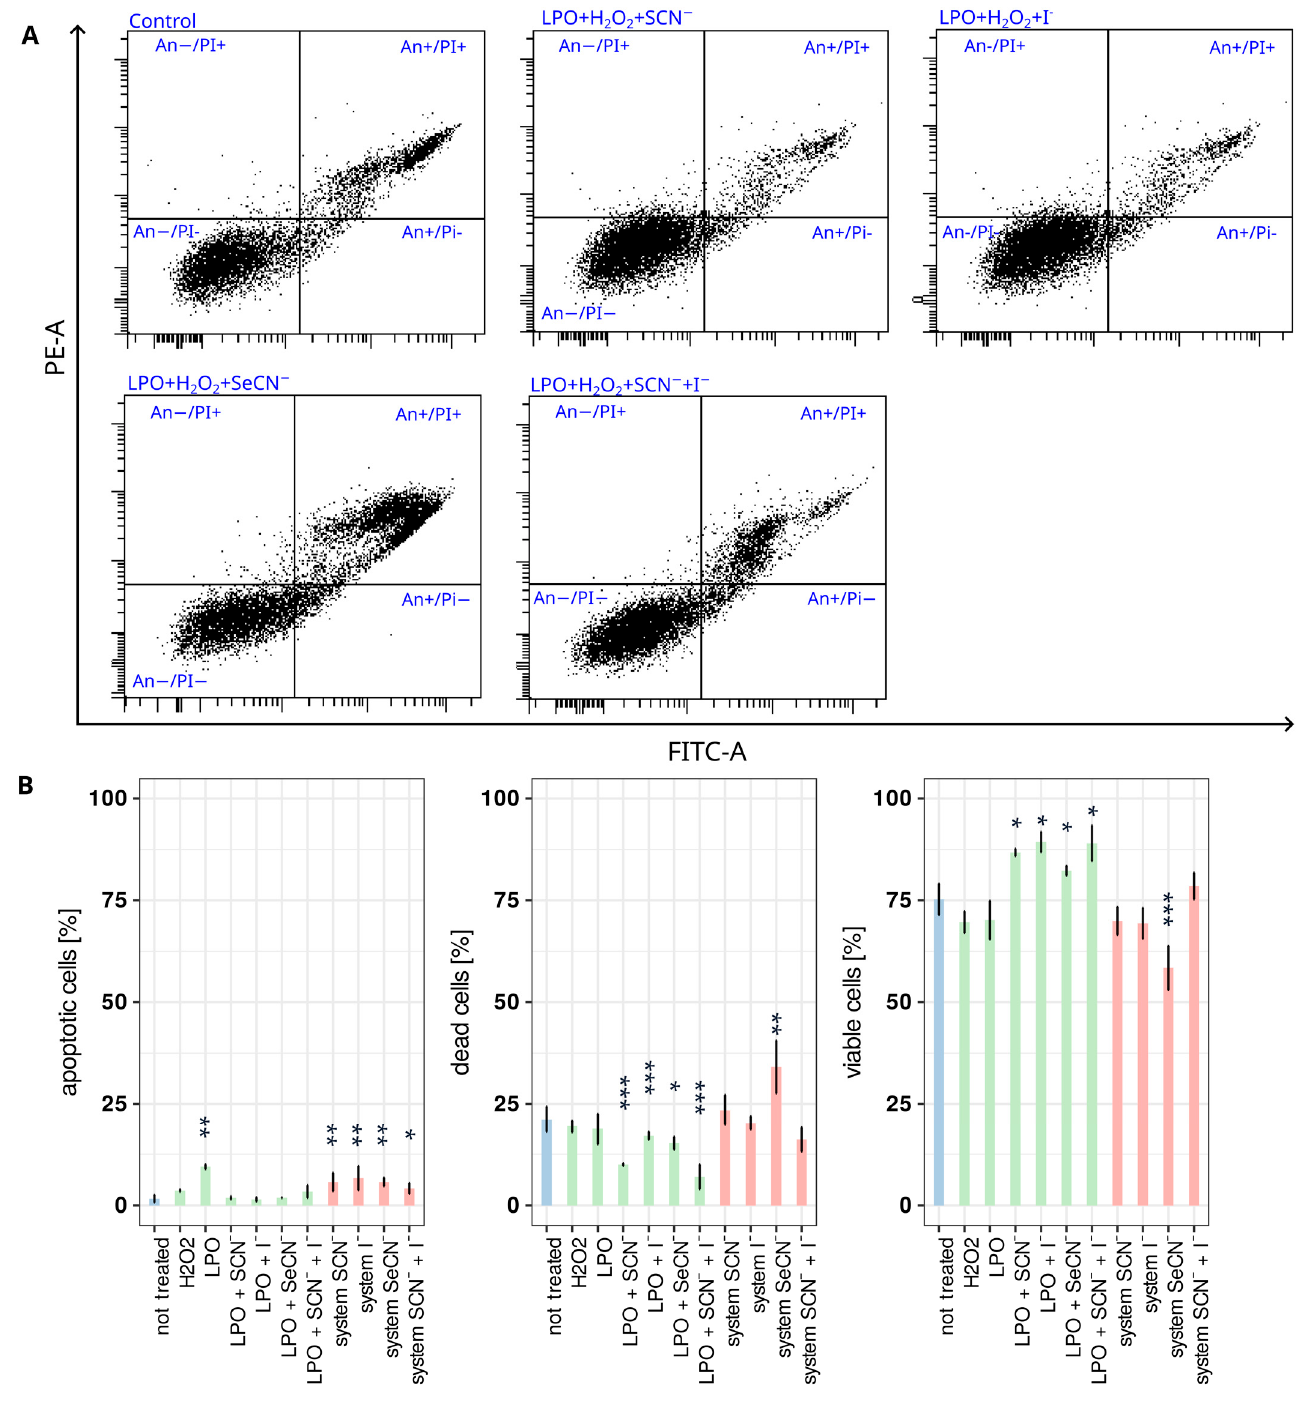
Figure 1. Influence of tested systems on HGF apoptosis. ( A ) Representative scattergrams of cell distribution after staining with the apoptosis assay kit. Each segment of the scattergram is labelled as: An − /Pi − —viable cells, unstained with either annexin V or propidium iodide; An+—apoptotic cells, stained with annexin V; An+/PI+—dead cells, stained with both annexin V and propidium iodide; PI+—stained with propidium iodide. ( B ) Bar plots show the percentage of apoptotic cells, dead cells, and viable cells after 1 h of treatment with tested systems. Colours indicate sample types where (i) blue denotes the control, (ii) green denotes an inactive LPO system (enzyme + (pseudo)halide), and (iii) red denotes an active LPO system. Asterisks indicate a statistically significant difference between a tested group and the control in the post hoc Tukey’s test—* p < 0.05; ** p < 0.01; *** p <